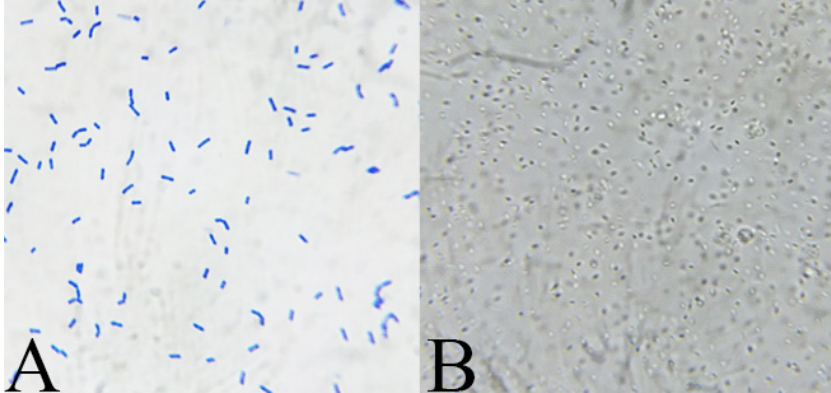
Figure 4. A novel strain under a microscope (х1000). A – Methylene blue-stained cells. B – The